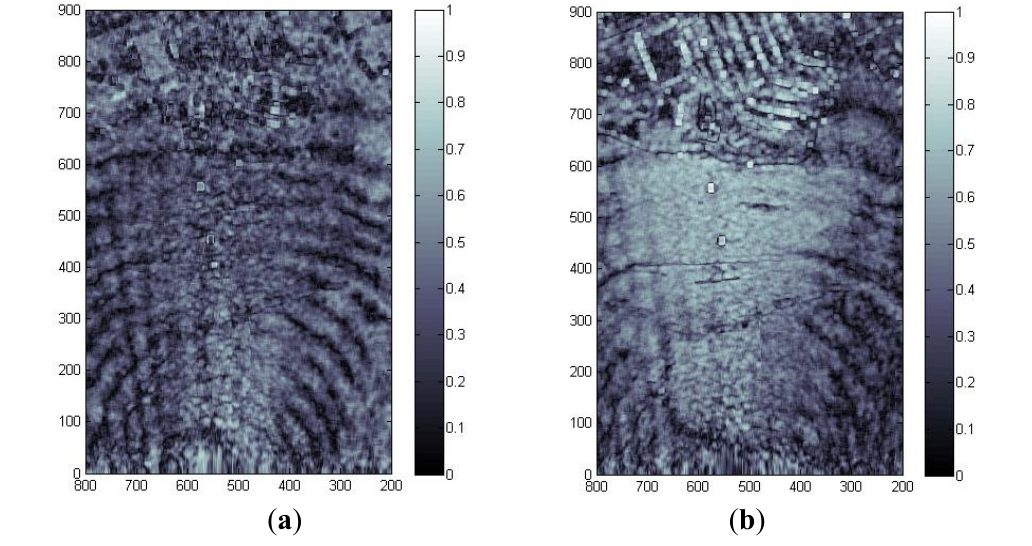
Figure 10. Coherence map from a 100 MHz bandwidth, single-pass, interferometric X-band measurement. ( a ) without and ( b ) with MoCo (x-axis is azimuth and y-axis range in meters).